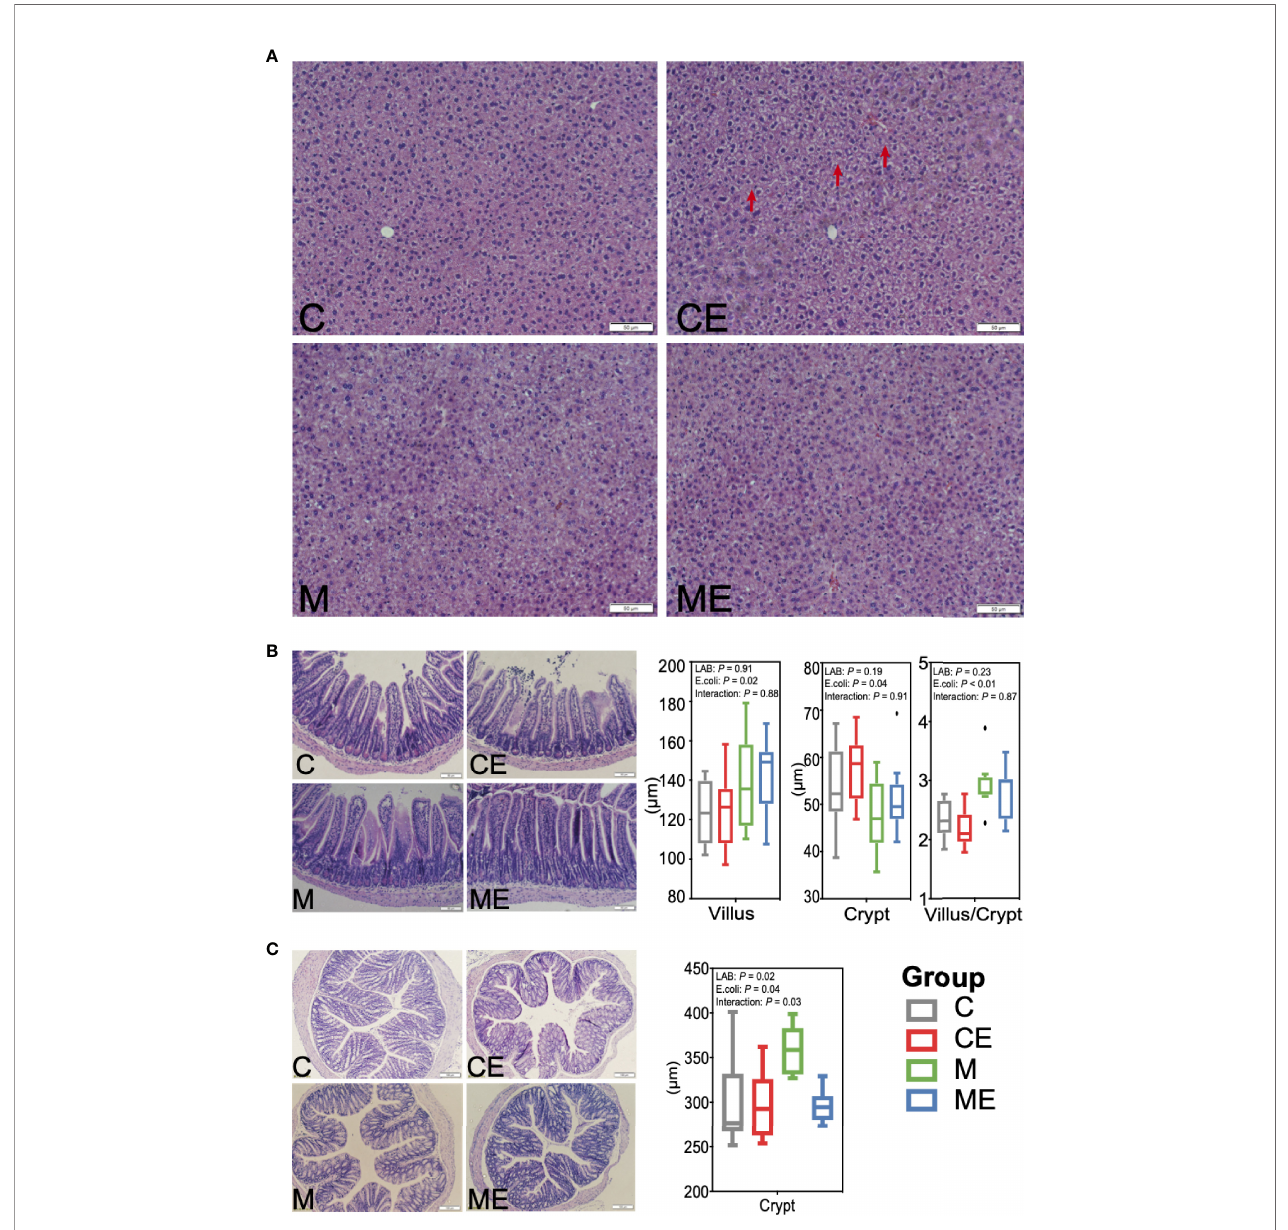
FIGURE 4 | Morphology of the (A) liver, (B) ileum, and (C) colon in control mice (C), control mice challenged with Escherichia coli (CE), mice fed mixed LAB strains (M), and mice fed mixed LAB strains and challenged with Escherichia coli (ME) at the end